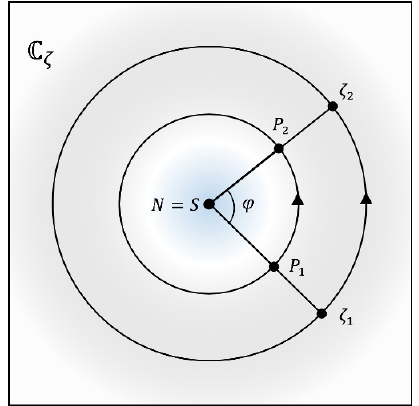
Figure 3 . The point P 2 on S + is obtained from P 1 by means of a rotation about the x 3 axis. The corresponding orbit in C (cid:16) is a